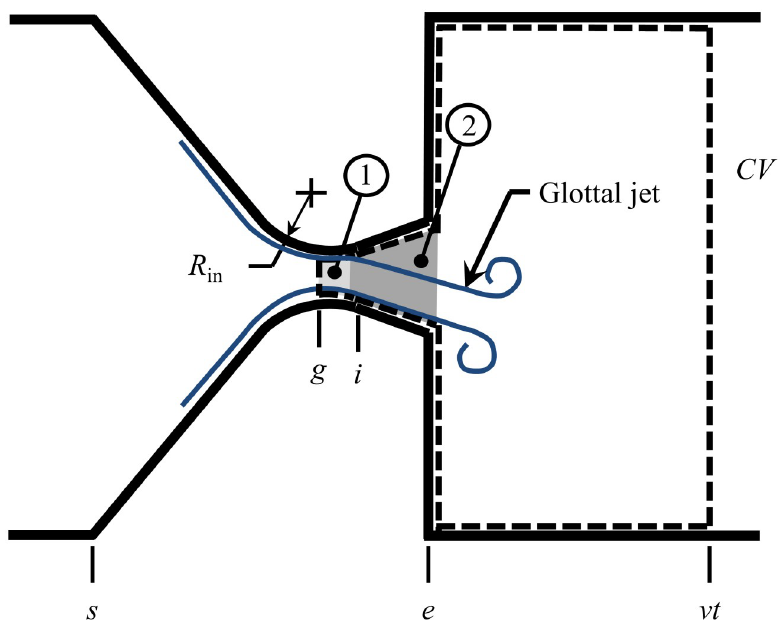
Fig 1. Schematic of the glottal fluid and acoustic model domain. Region (1) denotes where the effects of flow curvature are modeled, while (2) identifies where the Boundary Layer Estimation of the Asymmetric Pressures (BLEAP) model is applied. [28]. Locations of interest are identified as: s —subglottal; g —glottis, i —inlet, e —exit, vt — vocal tract.